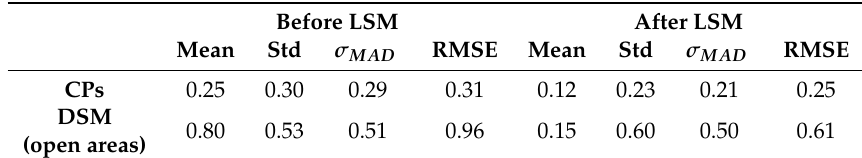
Table A1. Vertical accuracy assessment of Pléiades DSM w.r.t. CPs and the entire scene in open areas (values are in meters).